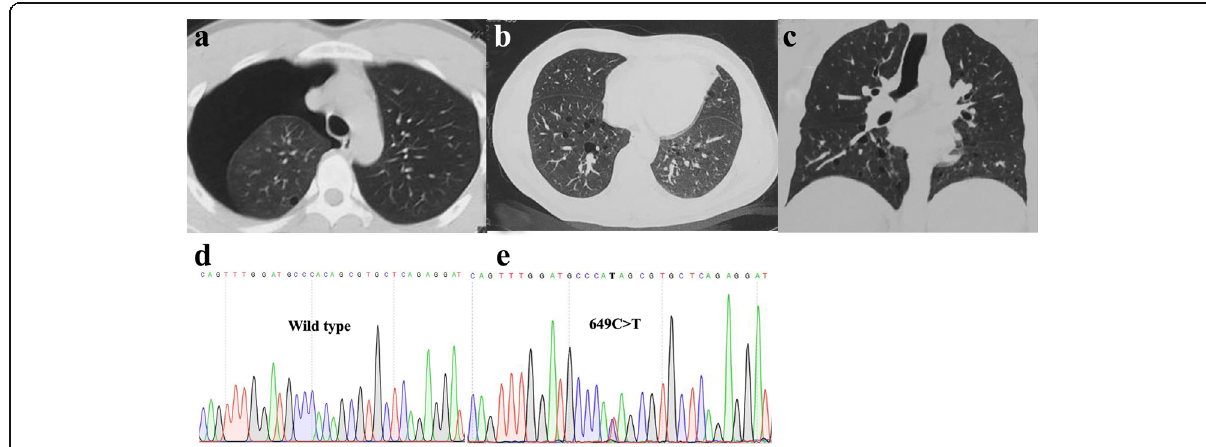
Fig. 4 Examination results and Sequence diagram of family 2. a Computed tomography scans showing pulmonary cyst and pneumothorax (III2). b , c Multiple pulmonary cysts and pneumothorax in the lung of the proband ’ s father (II1). d , e Direct sequencing of exon7 of FLCN revealed the nonsense mutation: c.649C > T on exon 7